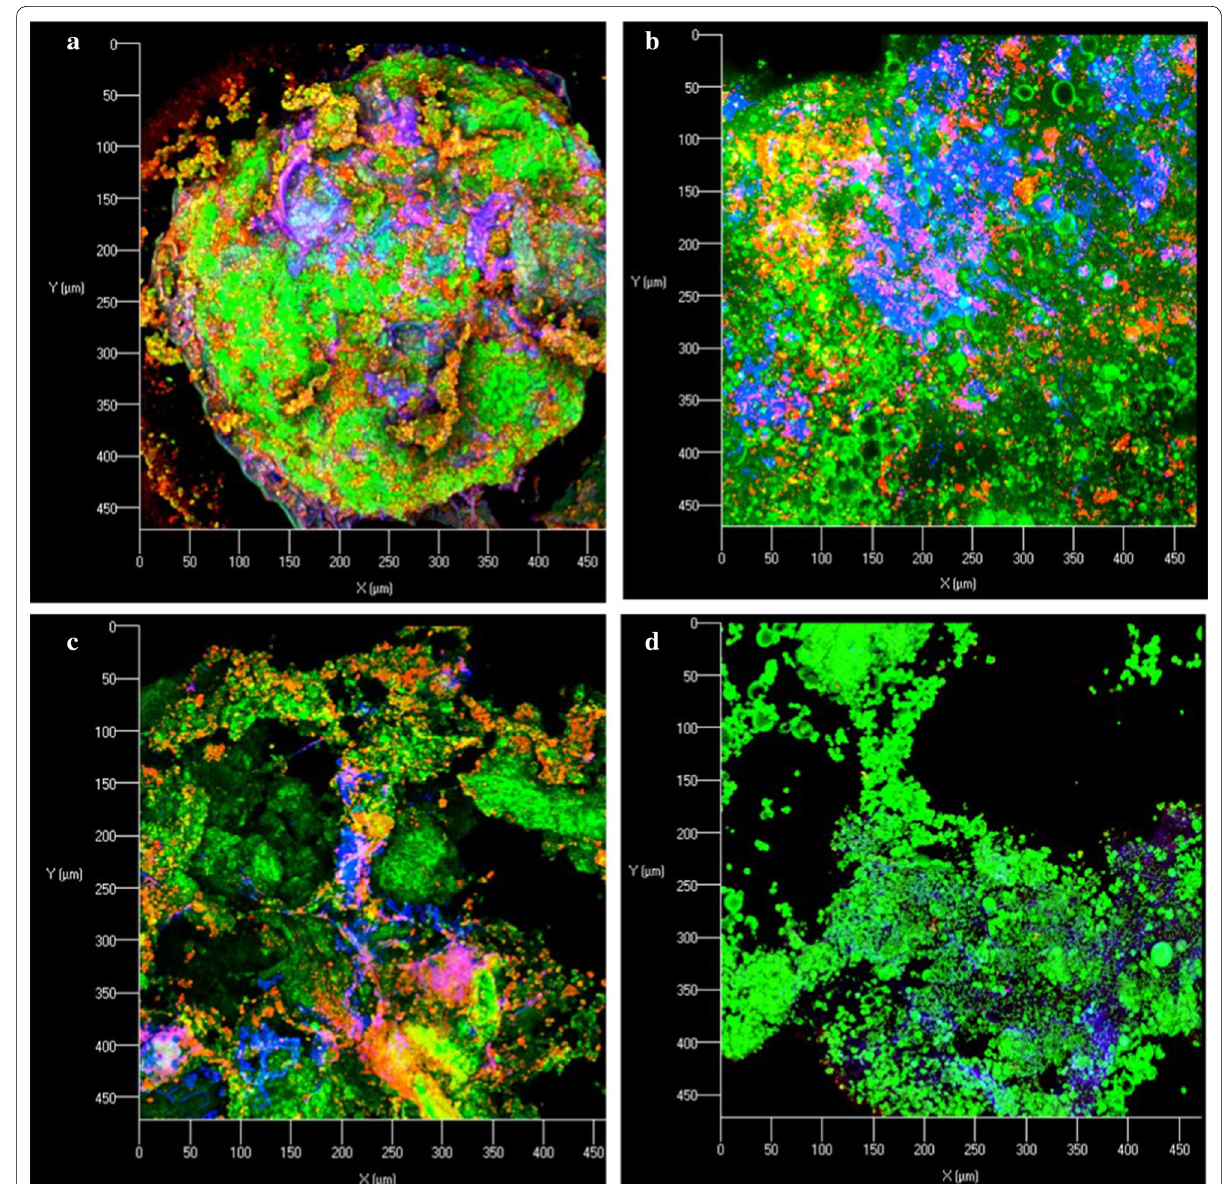
Fig. 3 Confocal laser scanning microscope images (475 μm A (Con A)-stained CDDGS ( a ), RDDGS ( b ), FCDDGS ( c ) and FRDDGS ( d ),